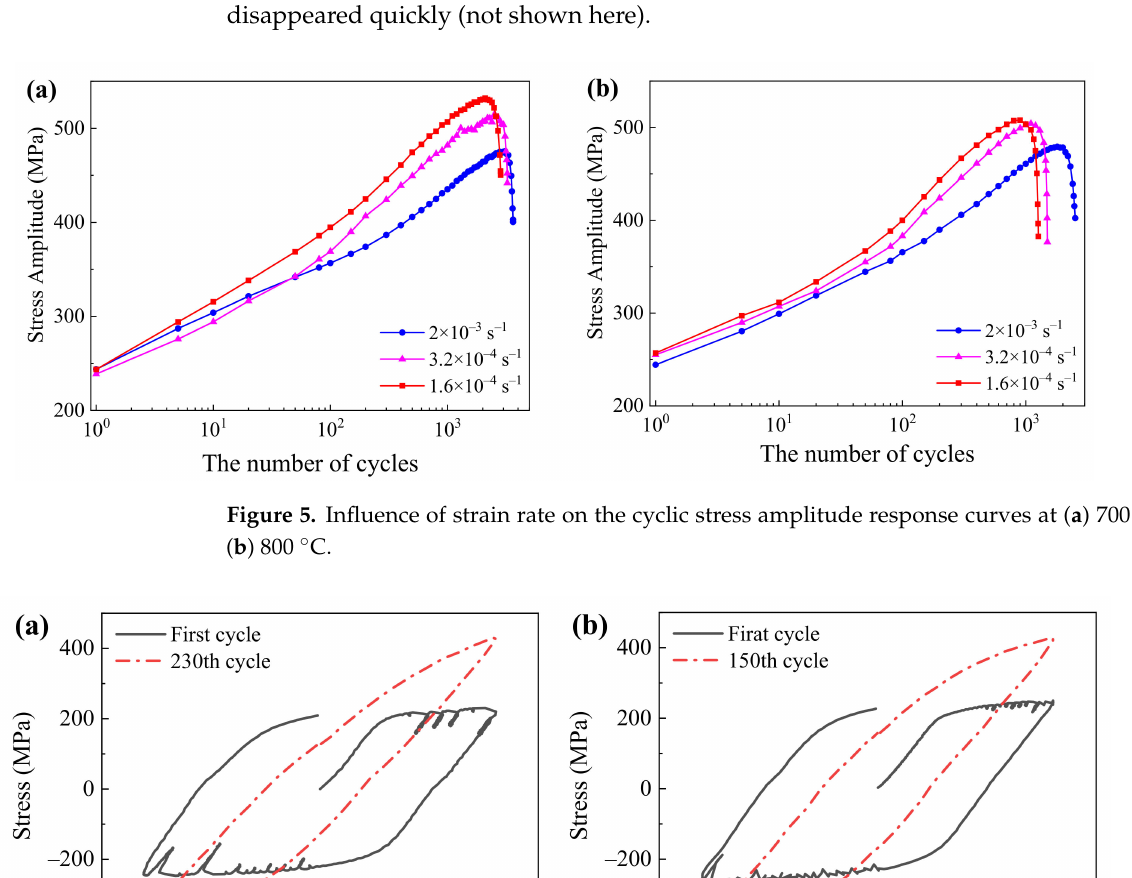
Figure 6. DSA effect reflected by hysteresis loops (